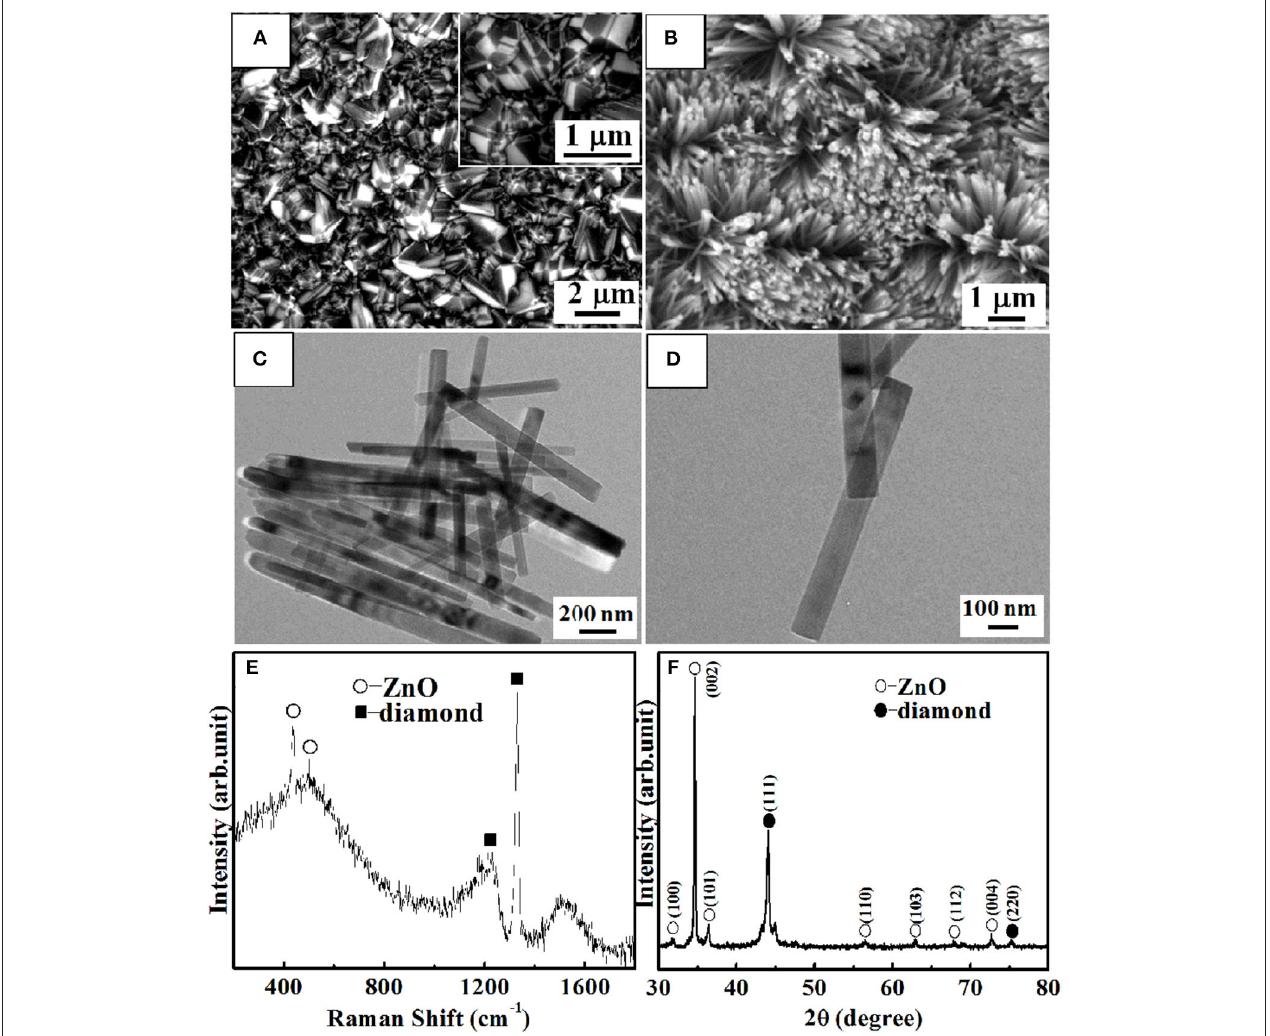
FIGURE 1 | SEM images of p-degenerated diamond (A) and n-ZnO NRs (B) grown on p-degenerated diamond. TEM images of the as-synthesized n-ZnO NRs at 200-nm (C) and 100-nm (D) magnifications. Raman spectra (E) and XRD patterns (F) of n-ZnO NRs/p-degenerated diamond